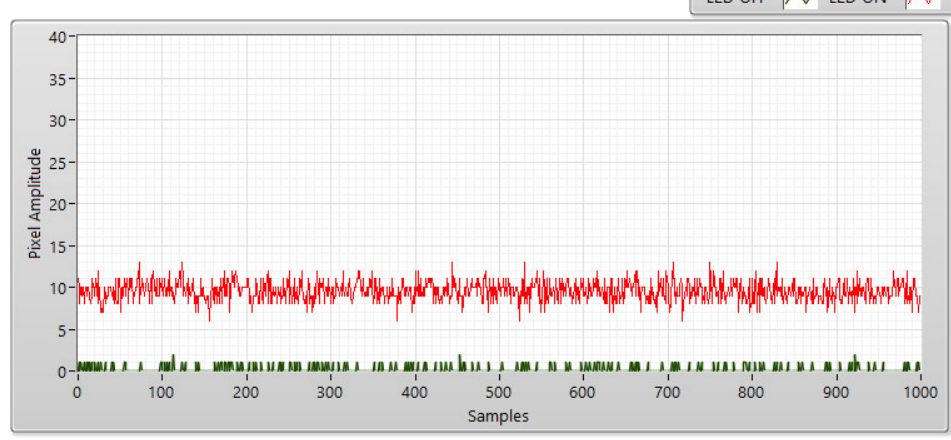
Figure 8. The SNR measurement using a rolling-shutter camera at 15 m and a 50 μs exposure-time setting.